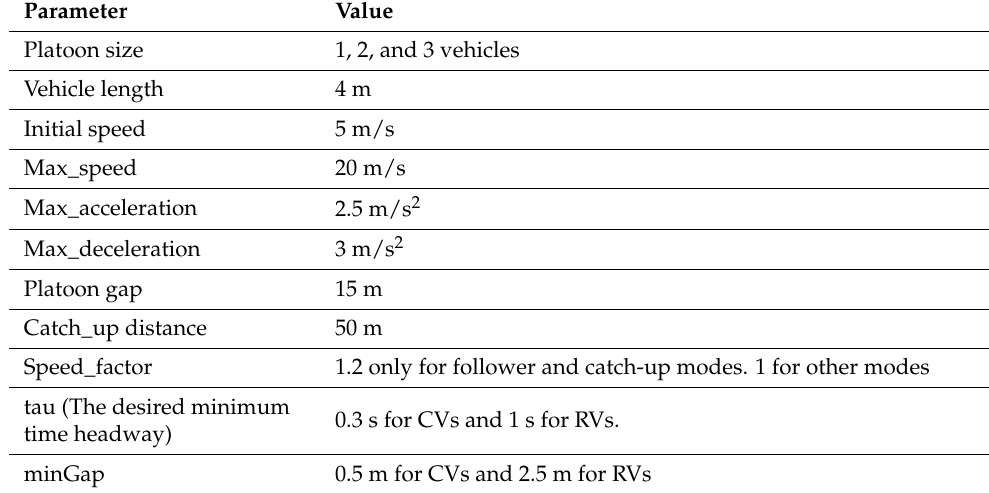
Table 1. Attributes of